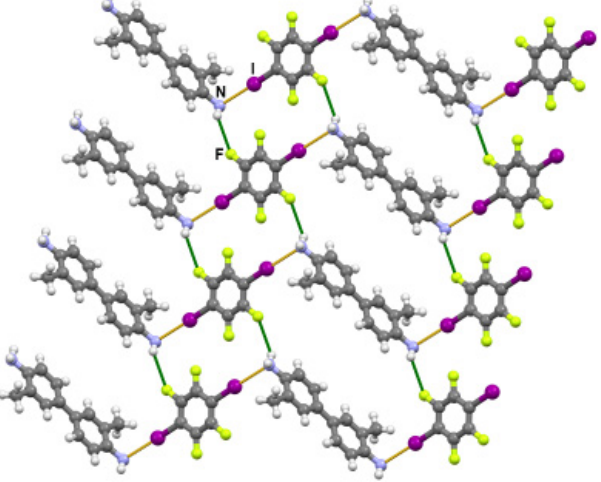
Figure 2. In the structure of ( otol )( 14tfib ), layers are formed by the linking of halogen-bonded (yellow) chains through N − H · · · F hydrogen bonds (green) in the structure of ( otol )( 14tfib ). Unlike pphda , otol also formed a cocrystal with the tritopic halogen bond donor, 135tfib . Unlike the cocrystals with 14tfib which were of the expected 1:1 stoichiometry (resulting from a ditopic donor binding with a ditopic acceptor), this was found to present a somewhat unexpected 1:2 stoichiometry with the formula ( otol )( 135tfib ) 2 , significantly deviating from the 3:2 stoichiometry which might be expected based on the respective topicities of the acceptor and the donor. In the crystal structure of ( otol )( 135tfib ) 2 cocrystal, again both otol amino groups participate in I ··· NH 2 halogen bonds ( d (I1 ··· N1) = 3.035(8) Å, ∠ (C7–I1 ··· N1) = 176.9(2) ◦ ). Besides this main supramolecular interaction, both the π - systems of the aromatic diamine act as halogen bond acceptors, forming I · · · C π